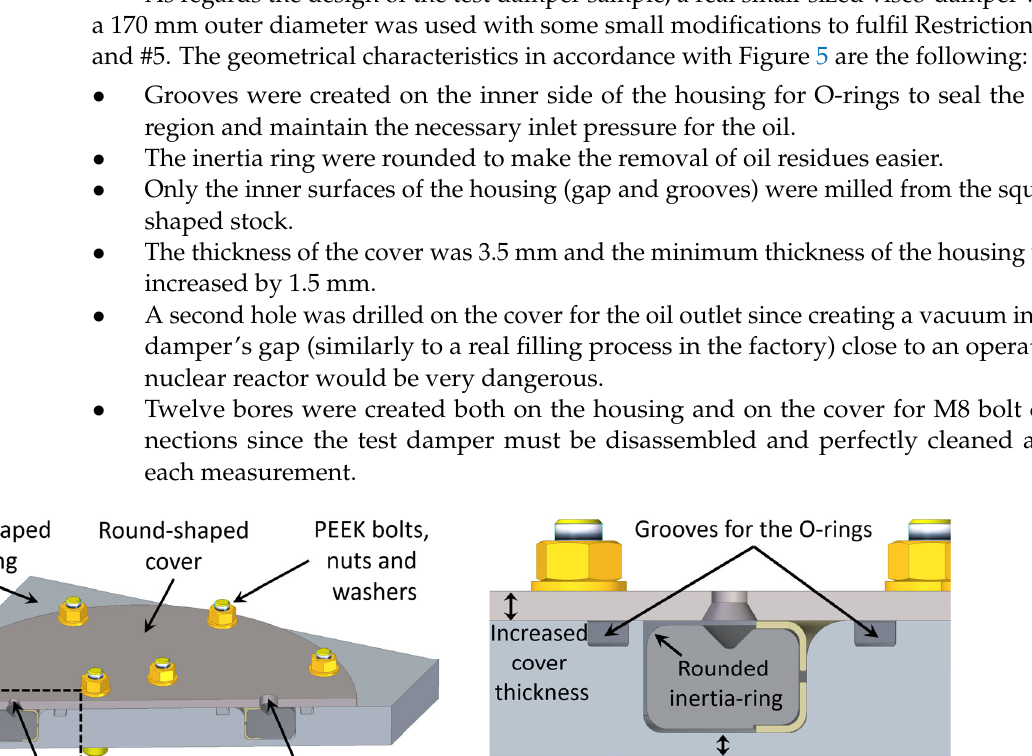
right after the measurement by fulfilling Restriction